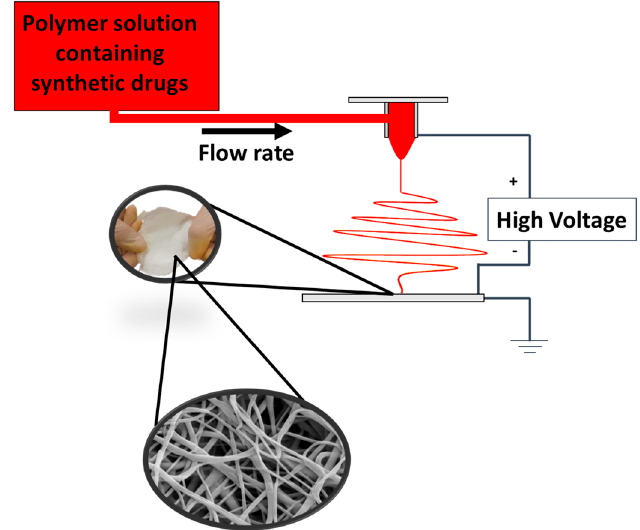
Figure 9. Electrospinning process.